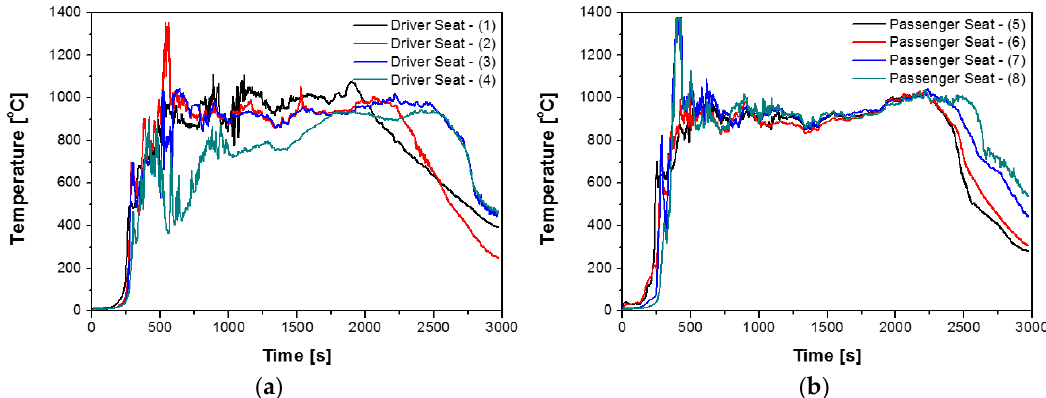
Figure 7. Temperature distribution on seats of the first vehicle; ( a ) temperature of driver seat in first vehicle and ( b ) temperature of passenger seat in first vehicle.